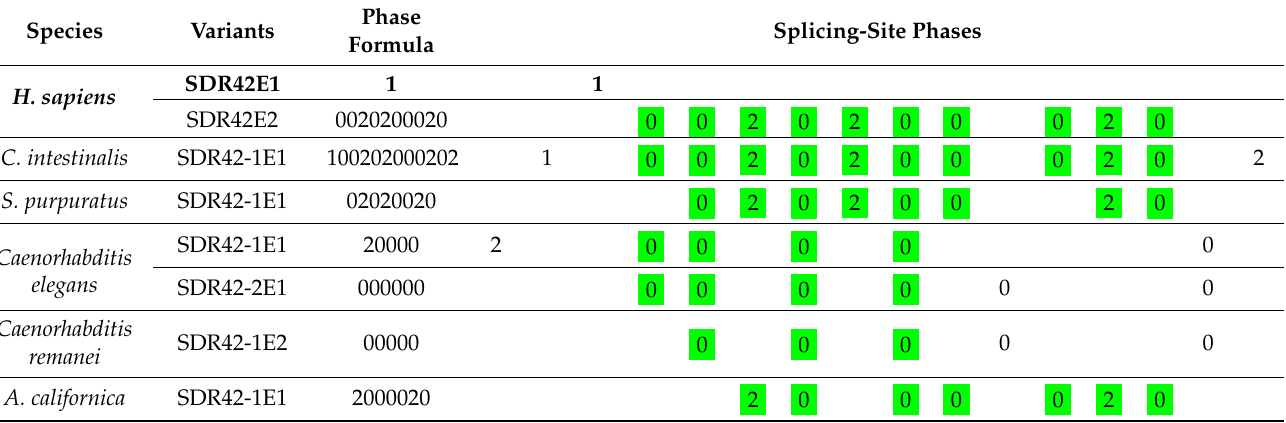
Table 6. Splicing-site organization of the human SDR42E family variants and their invertebrate orthologs. For further details see Table